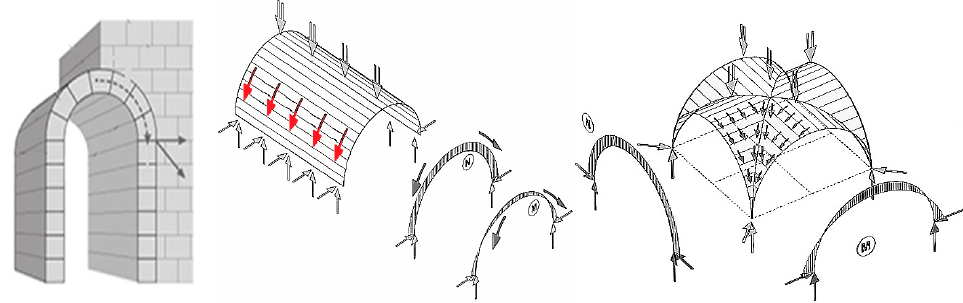
Figure 3. The thrusts of a barrel vault and a groin